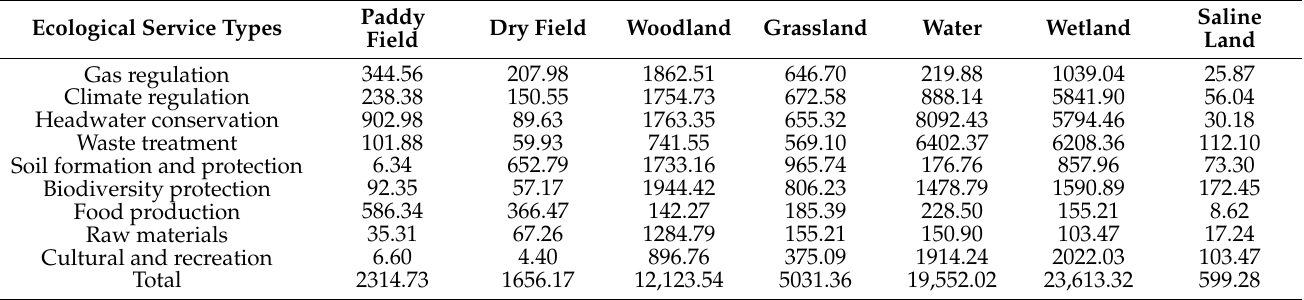
Table 5. Nature Reserve ecological service values per unit area (CNY/haa − 1 ). Ecological Service